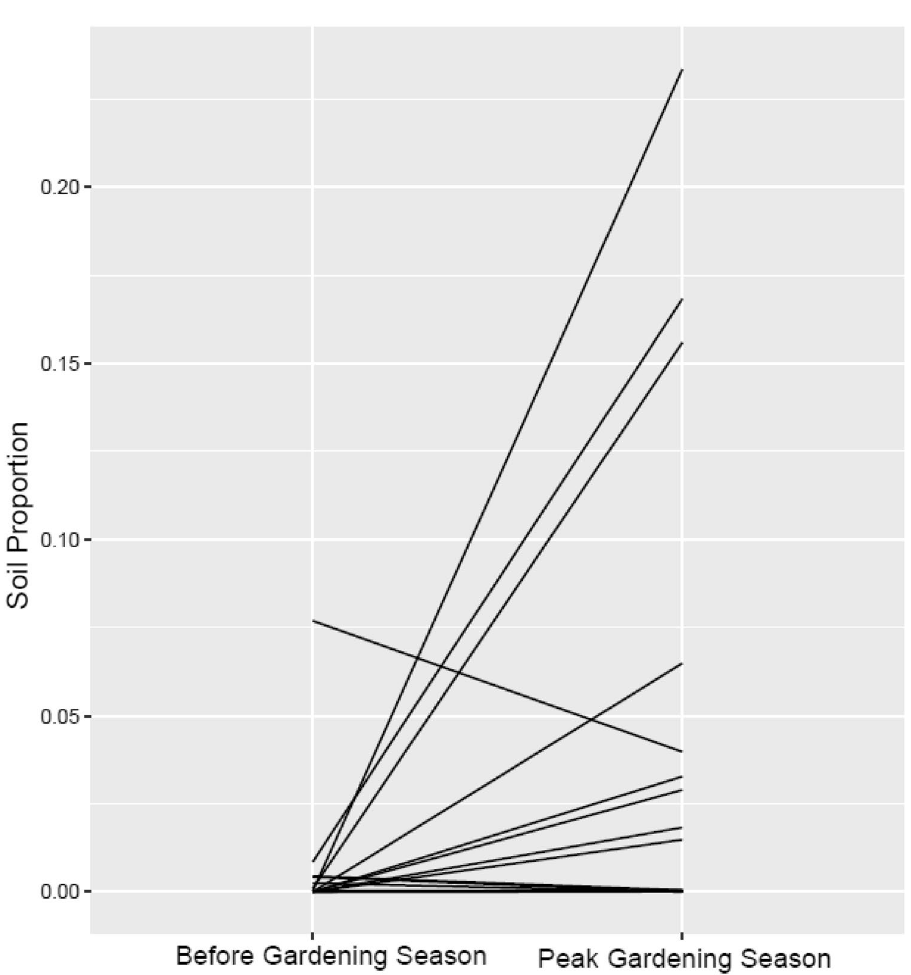
Figure 6. Estimations from FEAST output on contribution of soil (source) microbes to the gut (sink) of gardening families from before the garden season to peak garden season. Lines represent the gain or loss of soil endemic microbes during the gardening